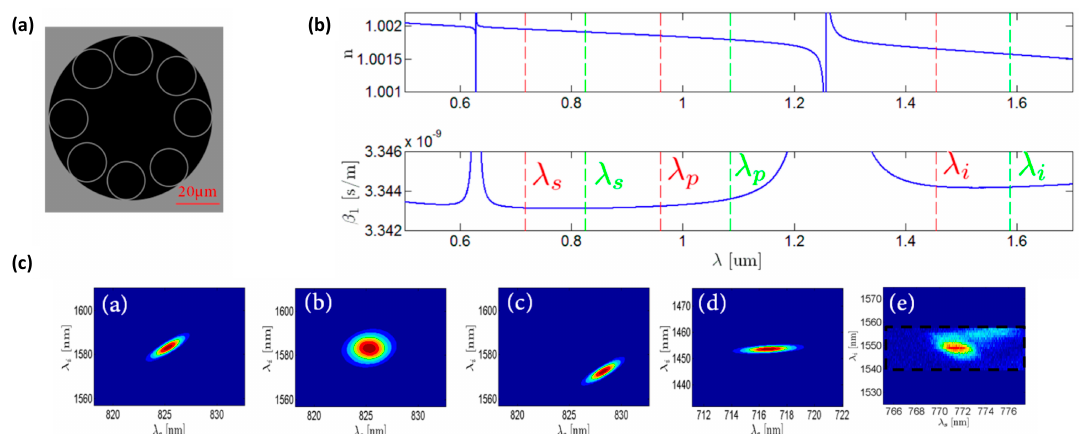
Figure 31. ( a ) SEM image of the 8 tubes IC fiber cross-section used for JSI experiments. ( b ) Calculated fundamental mode effective index and inverse group velocity in an 8 tubes IC fiber filled with 3-bar Xenon. Two specific four-wave-mixing configurations are identified with respectively the fulfillment of β 1 ( ω p ) = β 1 ( ω s ) and 2 β 1 ( ω p ) = β 1 ( ω s ) + β 1 ( ω i ). ( a – d ) Simulated and ( e ) experimental JSI for different lengths, gas pressures, and pump wavelengths (reprinted with permission from Reference [146], OSA, 2018).